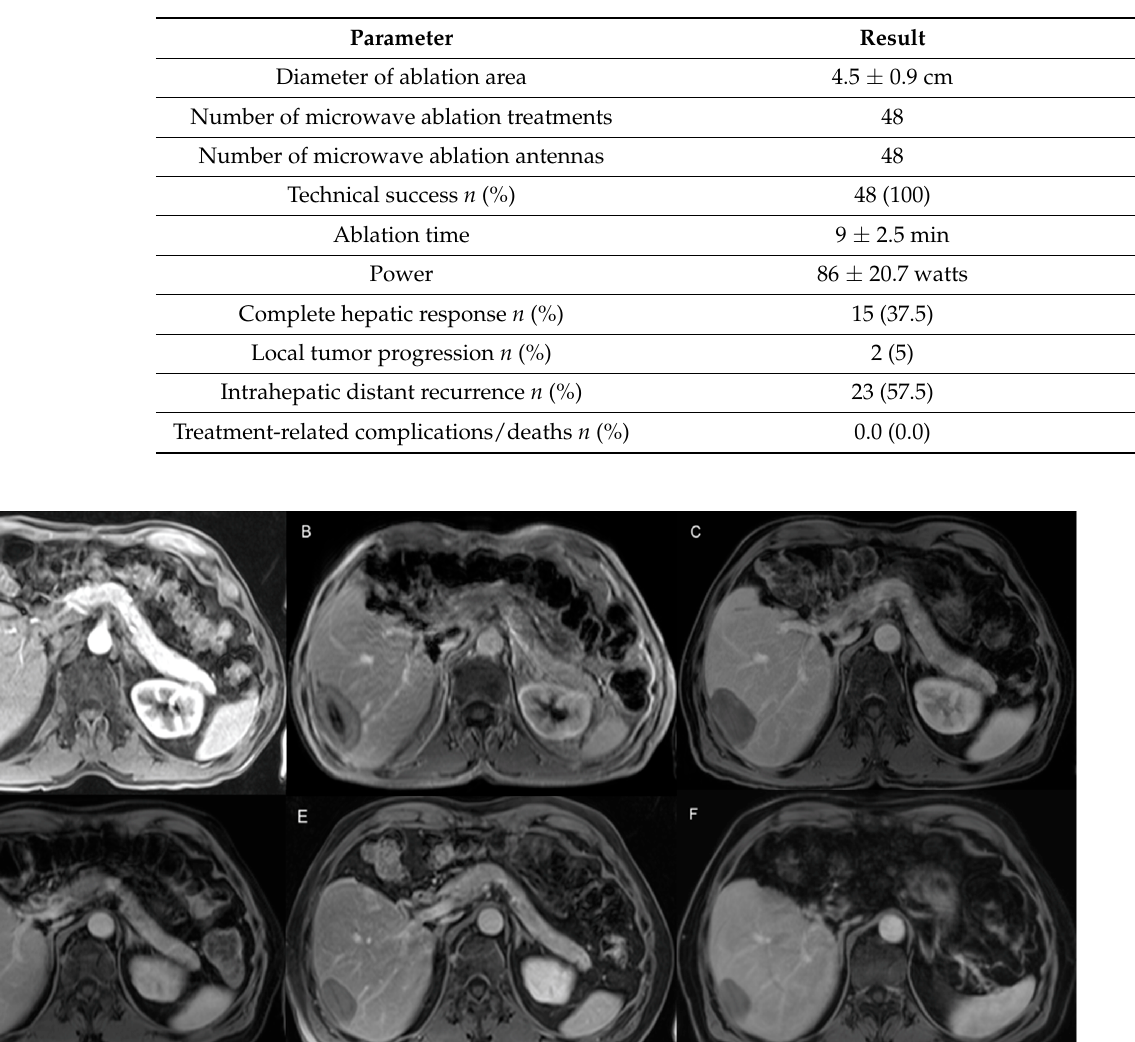
Table 3. Survival for all patients.